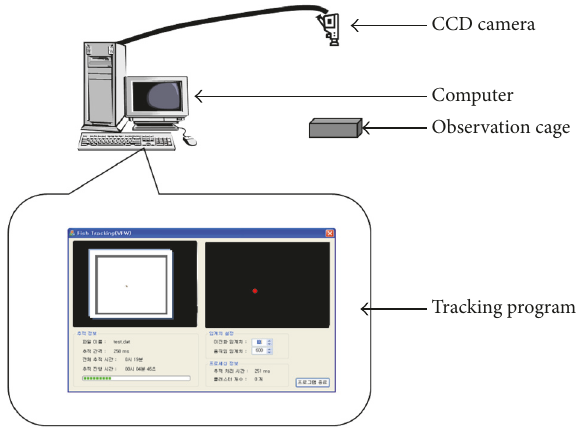
Figure 1: Behavior observation system for Daphnia